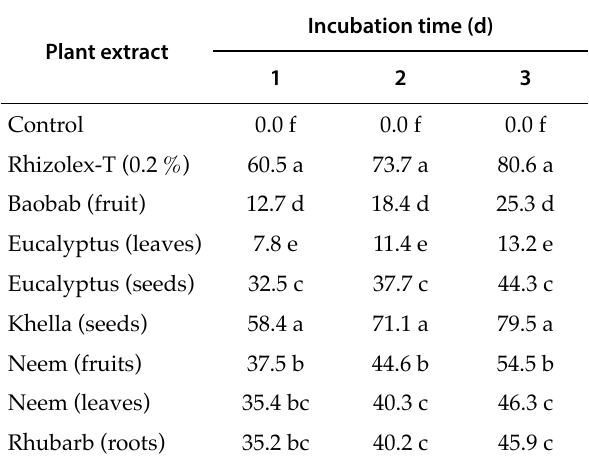
Table 3. Mean growth reduction (%) of Rhizoctonia solani mycelium when exposed to methanol extracts of various medicinal plants at 10% concentrations.